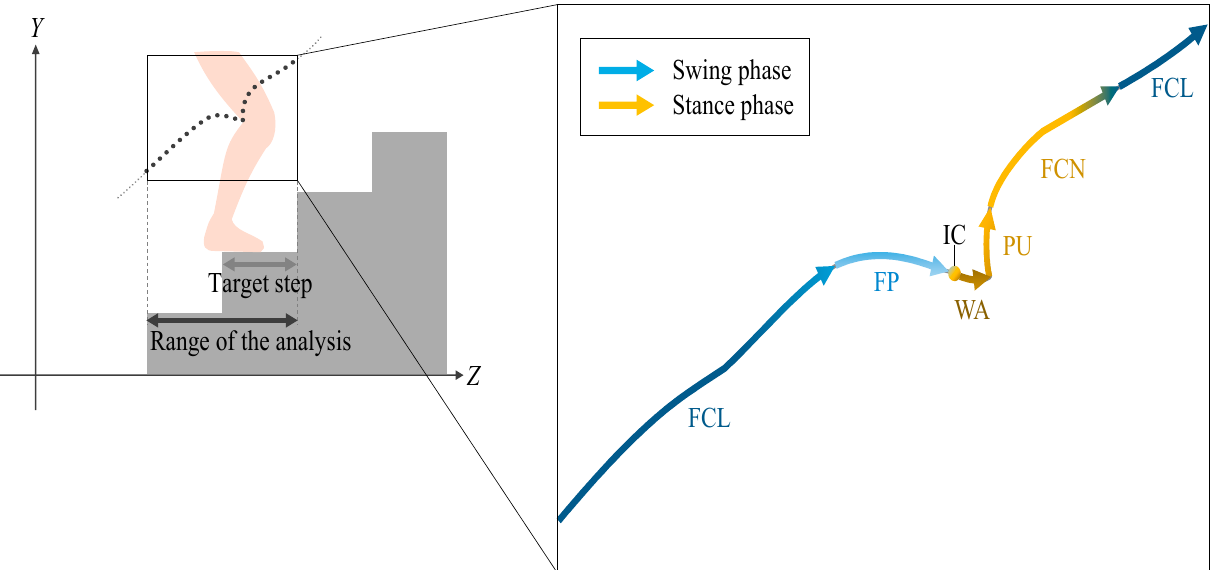
Figure 2. Representative image of knee joint trajectory in one cycle of stair climbing. One cycle of the knee joint trajectory was extracted in the range of two steps. The target step includes the stance phase and the step before it. The swing phase consisted of foot clearance (FCL) and foot placement (FP), while the stance phase started from the initial contact (IC) and consisted of weight acceptance (WA), pull-up (PU), and forward continuation (FCN).